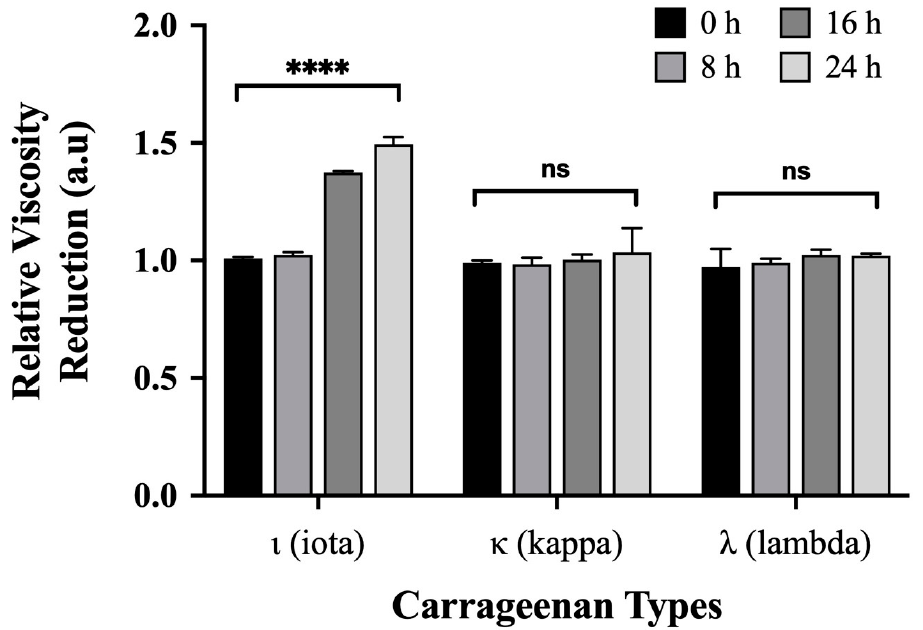
Figure 2. Degradation of ι , κ or λ -carrageenan using Paenibacillus strain YYML68. The concentration of the carrageenan types was 1%, 1%, and 2% respectively. Samples were measured at 0, 8, 16 and 24 h time points, and degradation was determined by the reduction in media viscosity in comparison to non-strain YYML68 treated samples. All samples were performed in triplicates. Statistical significance ( p < 0.05) was determined by t -test where **** indicates the level of significance. ns: non- significant.